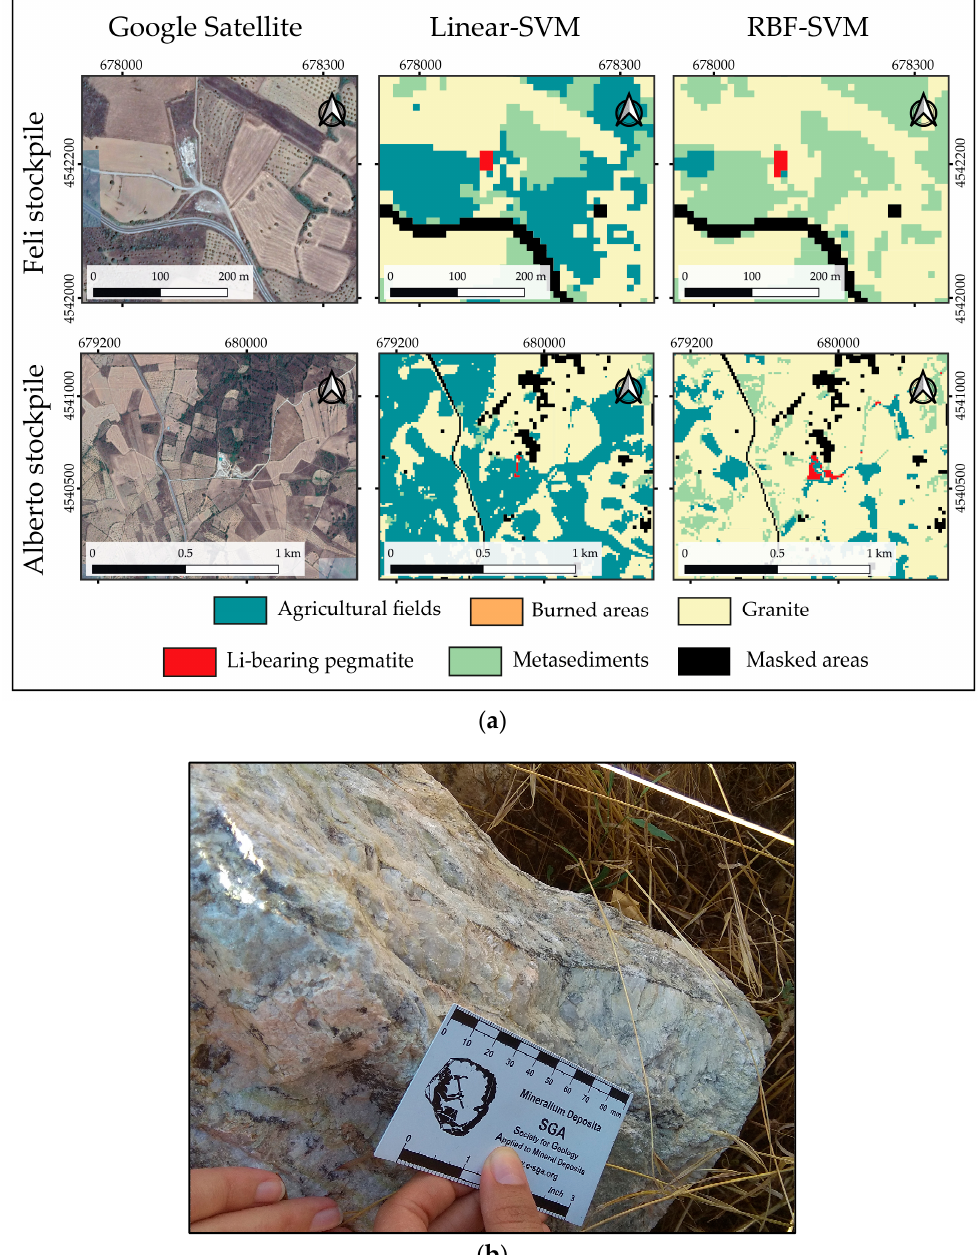
Figure 10. Evaluation of the models' performance in known ore stockpiles containing Li-bearing minerals ( a ). ( b ) Field photograph of a spodumene crystal (a Li-bearing mineral) from the Alberto stockpile.